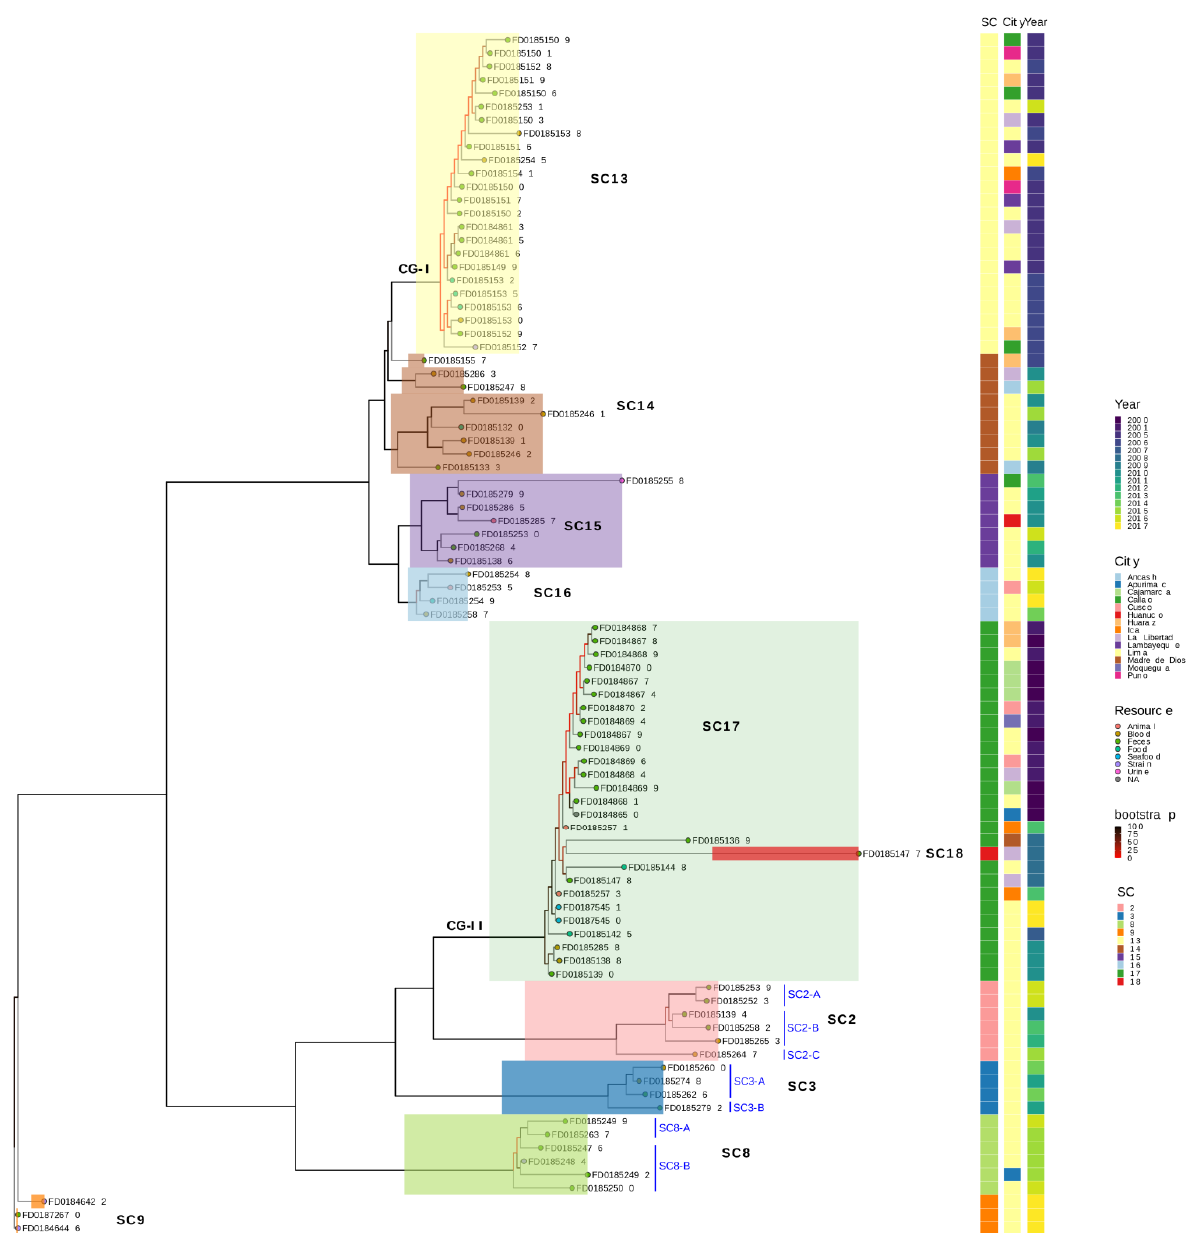
Figure 3. The phylogenetic tree was generated using a maximum likelihood method with 1000 replicates of bootstrap using GTR + GAMMA to estimate the evolutionary distance between Peruvian isolates ( n = 90). The phylogenetic tree was clustered into at least two large clades and separated into nine sub-clades. Each sub-clade corresponds to a population group, except for SC18. Two emerging clades (CG-I and CG-II) are also found. Additionally, we identified subgroups based on the prediction of only the Peruvian population structure, but they did not show the phylogenetic distinction.